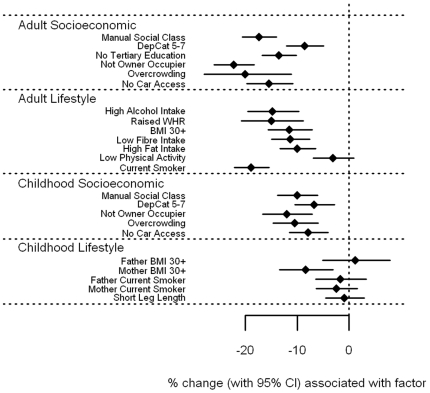
Associations between leutin and carotenoids and adult/childhood socioeconomic/lifestyle factors.